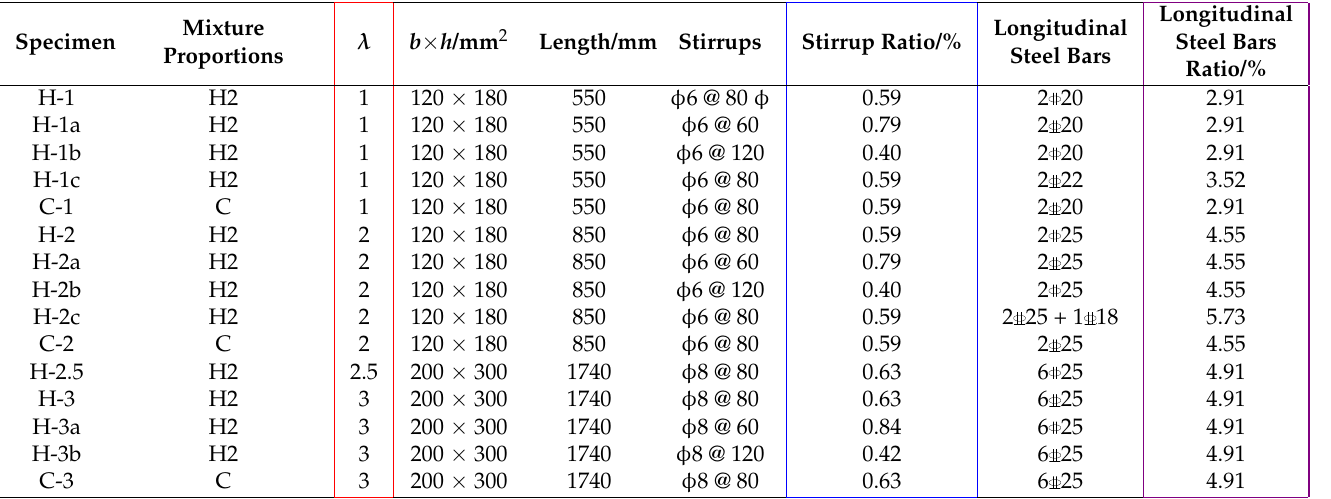
tudinal steel bar ratio, respectively.